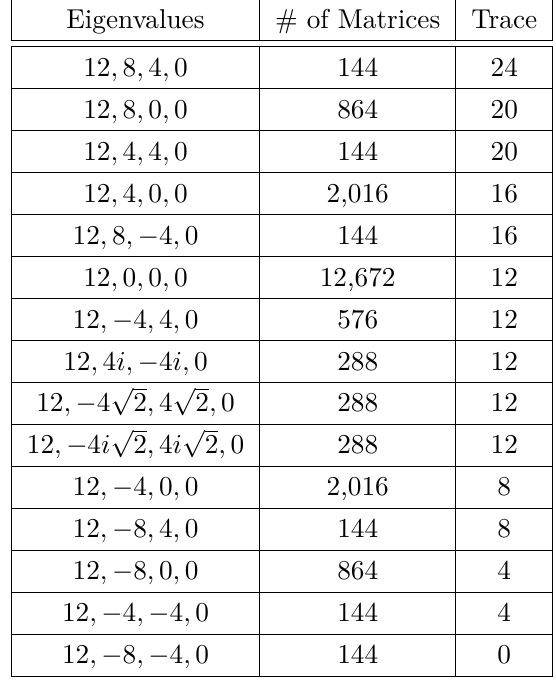
Table 22 . Eigenvalue equivalent classes of 20,736 distance